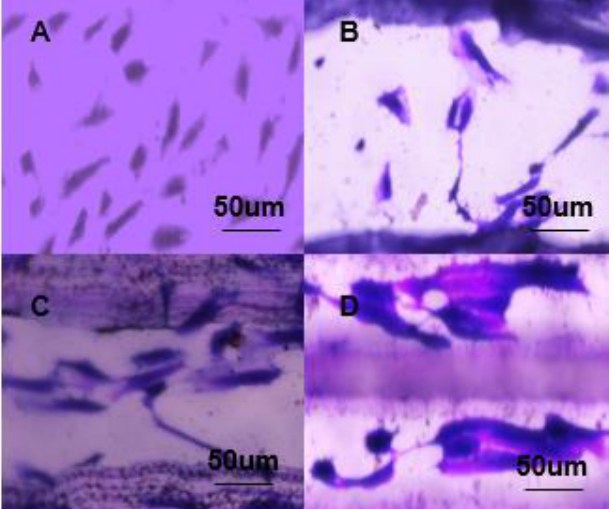
Figure 6. Cell growth on the first day: ( A ) unstructured PPDO film group, ( B ) pcl direct writing compound group, ( C ) pcl gelatin direct writing compound group, and ( D ) PPDO imprinted film group.